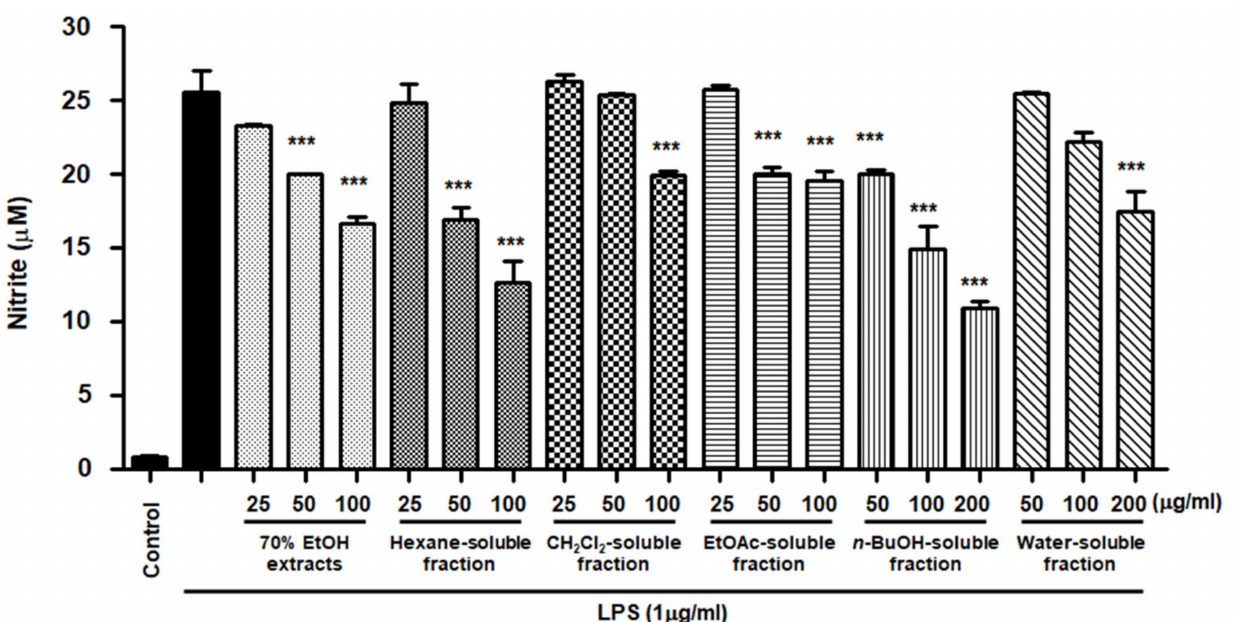
Figure 6. Effects of 70% EtOH extract and its n -Hexane-, CH 2 Cl 2 -, EtOAc-, n -BuOH-, and water-soluble fractions on nitrite content in BV2 cells. Cells were pretreated for 3 h with indicated concentrations of S. horneri extract and its fractions, and stimulated for 24 h with LPS (1 µ g/mL). The measurement of nitrite concentrations is described in the Materials and Methods section. Bars represent the mean ± standard deviation of 3 independent experiments. *** p < 0.001 compared with LPS-treated group. Control means an untreated control group.